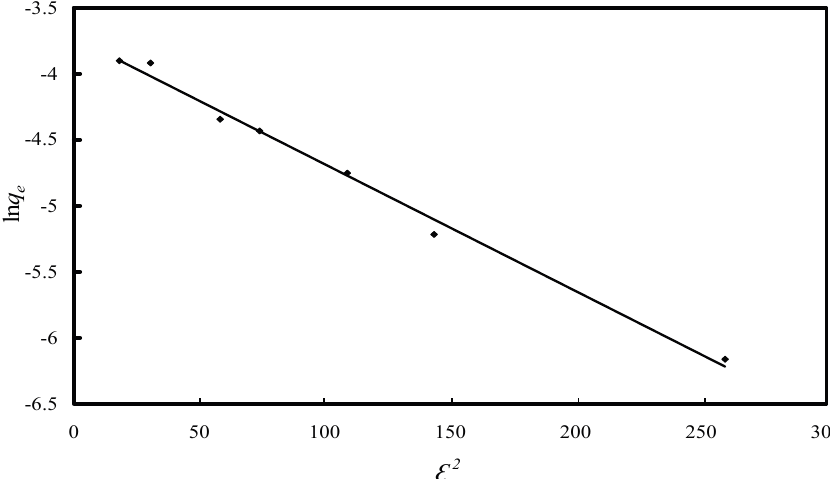
Figure 11. D-R isotherm model for As(V) adsorption onto Fe-XAD8-DEHPA